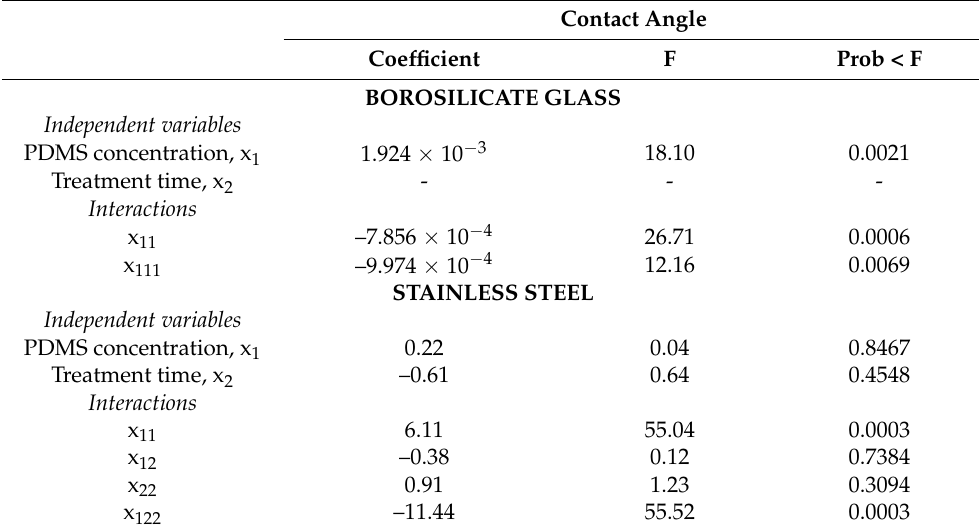
Table 5. Analysis of coefficients for the coded models used to fit the contact angle experimental data for the PDMS surface coating on borosilicate glass and stainless steel